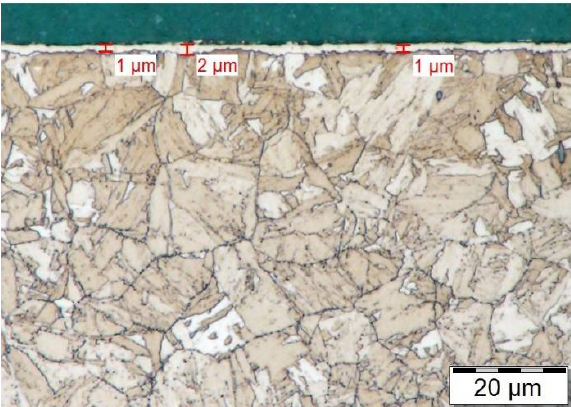
Figure 2. White layers of chemically heat treated specimens. ( a ) Six hours of gaseous ferritic nitrocarburizing and ( b ) 6 h of plasma ferritic nitrocarburizing. Magnification, 2000×.